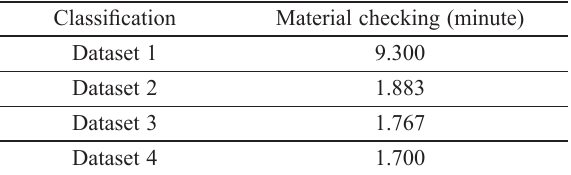
Table 6. Measured duration data for the activity of “ Material checking ” in the unloading process Classification